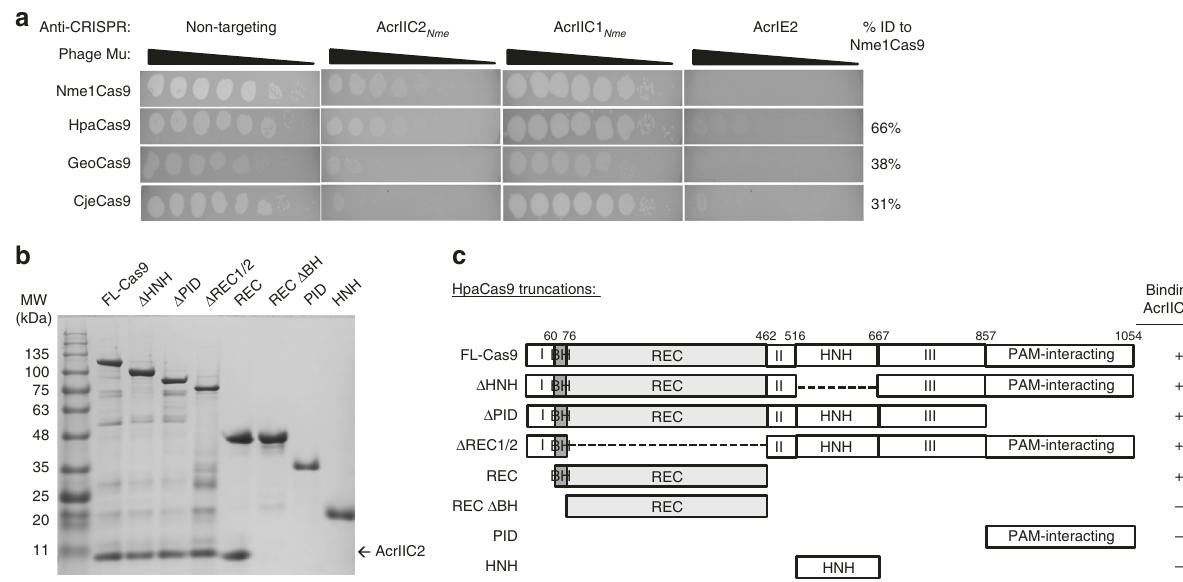
Fig. 1 AcrIIC2 Nme inhibits Cas9 activity through an interaction with the bridge helix. a Plaquing of E. coli phage Mu targeted by type II-C Cas9 proteins (Nme1Cas9, HpaCas9, GeoCas9, CjeCas9) in the presence of AcrIIC2 Nme , a type II-C anti-CRISPR with broad activity (AcrIIC1 Nme ) and a type I anti-CRISPR (AcrIE2). The sequence identity of the Cas9 proteins as compared to Nme1Cas9 is noted to the right of the fi gure. b Untagged anti-CRISPR was co-puri fi ed with 6x-His-tagged full-length HpaCas9, or domains thereof ( c ) using Ni-NTA af fi nity chromatography and the bound proteins were analyzed by SDS- PAGE and visualized using Coomassie staining. c Schematics of HpaCas9 truncations used to identify the domain with which AcrIIC2 Nme interacts. The bridge helix is denoted in dark gray, and the three sequence regions that comprise the RuvC domain are denoted as I, II, and